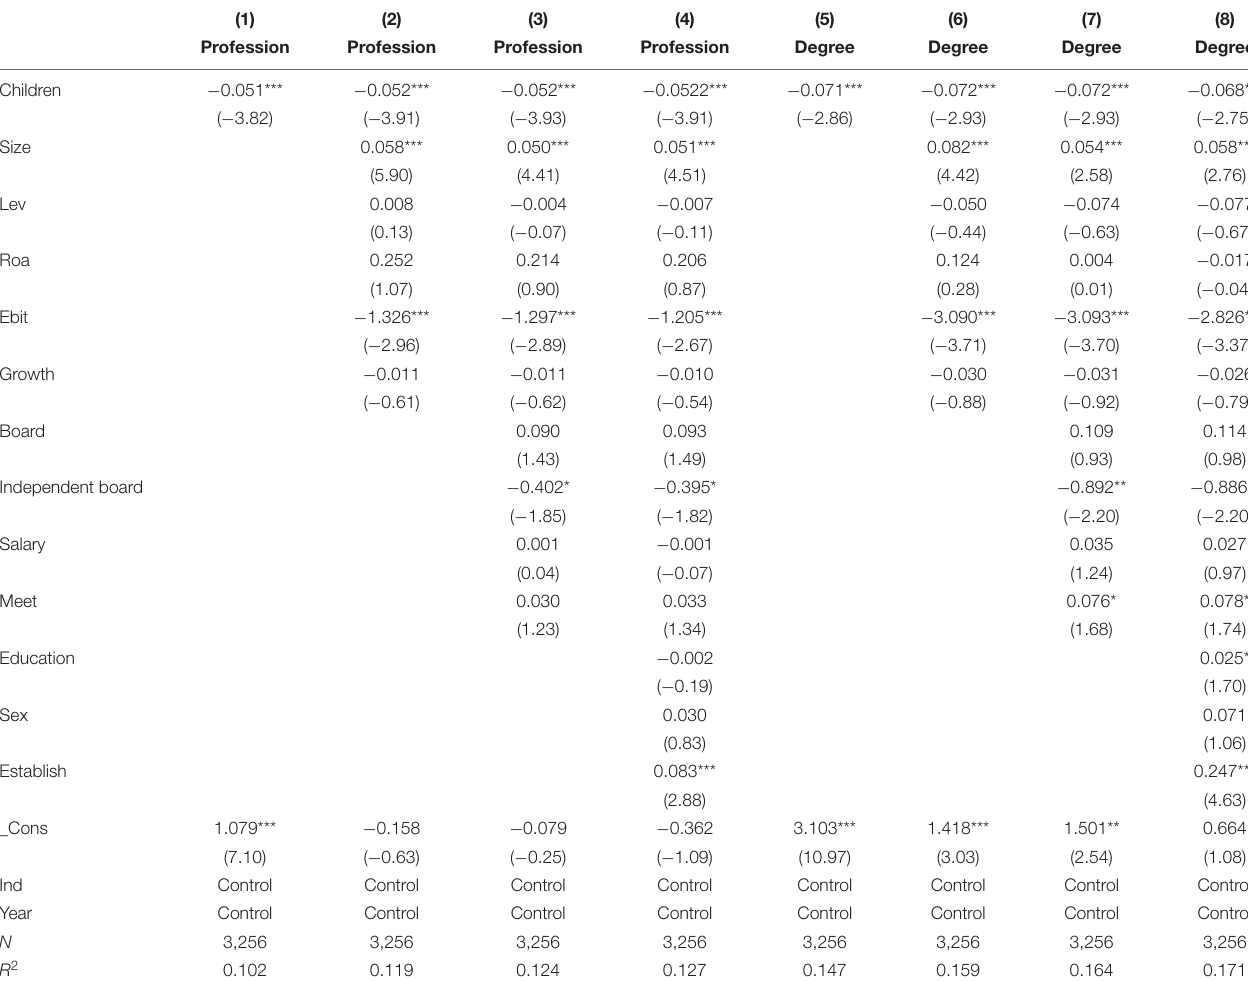
TABLE 6 | Change the sample size: the number of children of actual controllers and professional